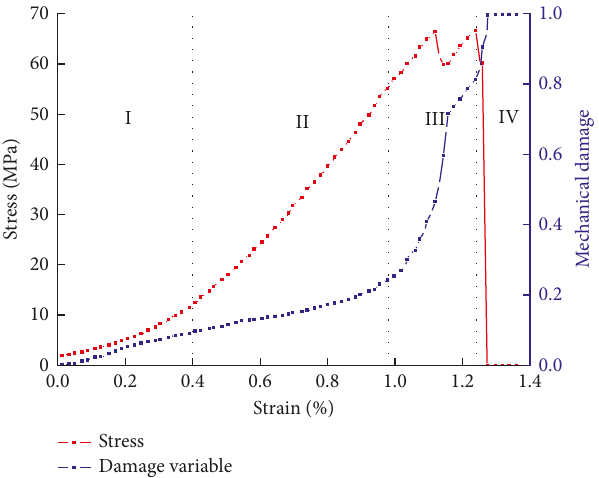
Figure 8: Mechanical damage and the stress-strain curve under uniaxial compression test at room temperature.